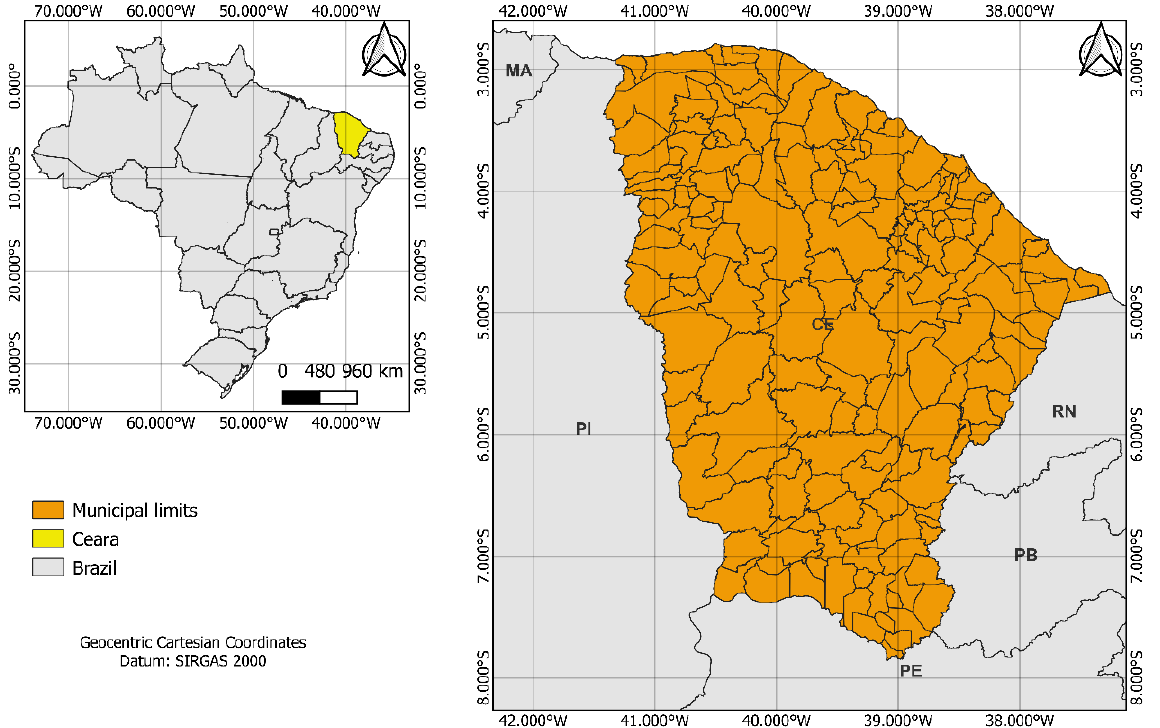
Figure 1. Geographic location of the study area. The acronyms indicate the states of the Northeast Region of Brazil that border the State of Ceará — CE: MA = Maranhão; PI = Piauí; RN = Rio Grande do Norte; PB = Paraiba; PE = Pernambuco.